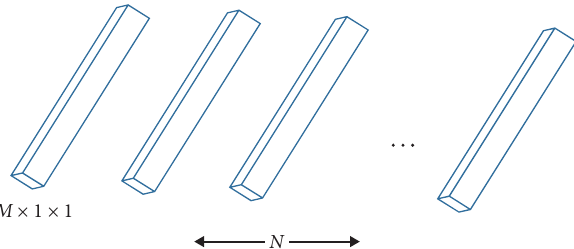
Figure 9: Combination of convolution equals accumulation convolution.